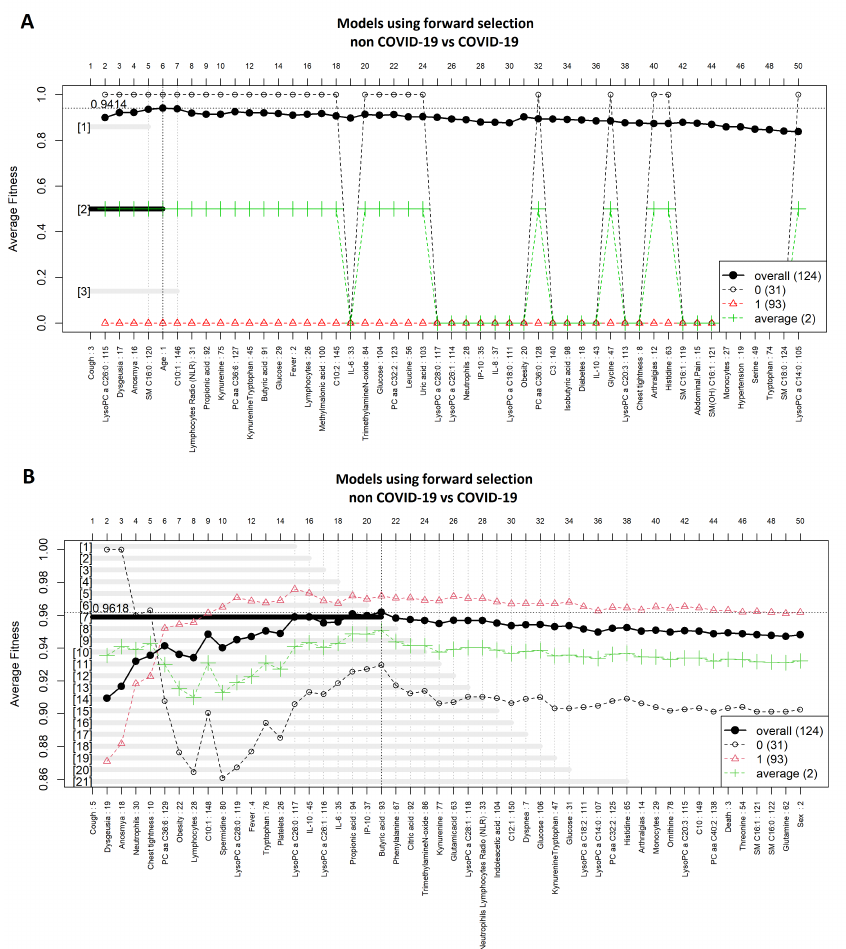
Figure A2. Forward selection model construction, for the prediction of COVID-19, ( A ) logistic regression and ( B ) support vector machine models. Forward selection process was performed by the most frequent feature obtained in the genetic search, then adding one feature at the time, after each feature, the accuracy of the model was obtained; if adding the feature increased the accuracy, the feature was kept. The vertical axis shows the classification accuracy. Solid line represents the overall accuracy calculated by measuring the misclassified samples divided by the total number of samples. Colored dashed lines represent the accuracy per class [36]. Note: The logistic regression function was computed using an external implementation coupled to the GALGO library; therefore, the dashed/average lines for said model could not be computed